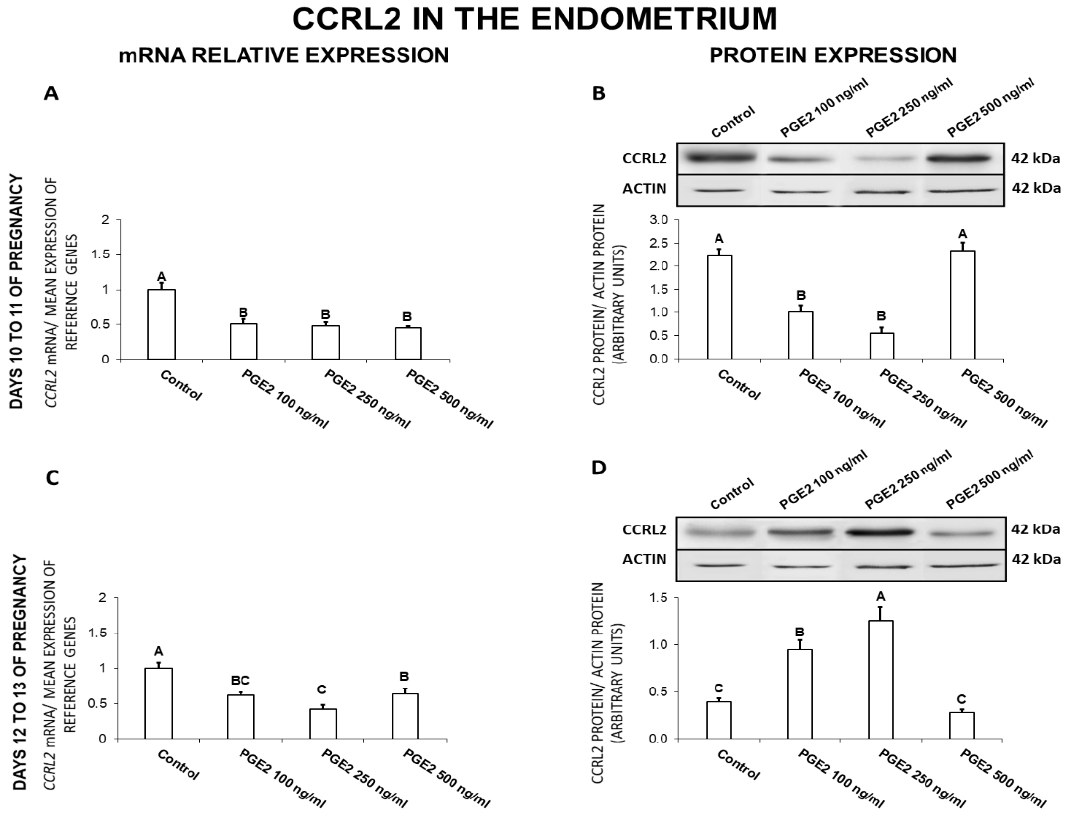
Figure 4 . The influence of prostaglandin E 2 (PGE 2 ; 100, 250, 500 ng/mL) on C-C motif chemokine receptor like 2 (CCRL2) mRNA ( A , C , E , G , I ) and protein ( B , D , F , H , J ) expression in the porcine